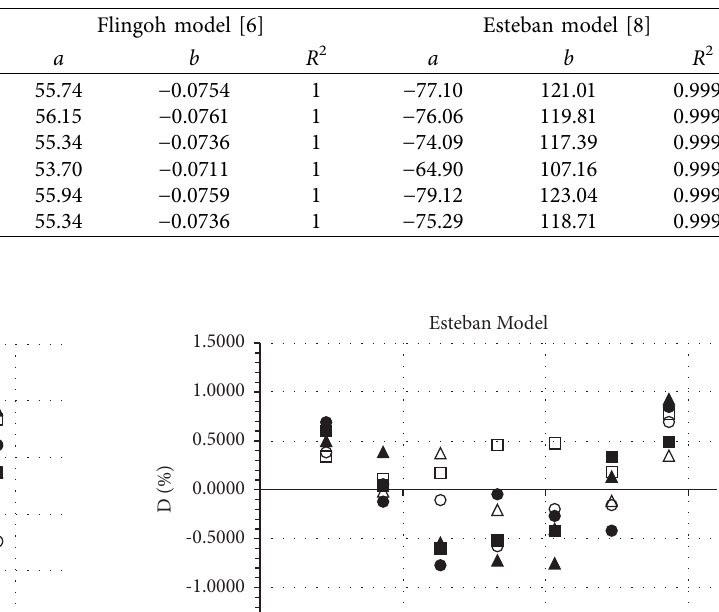
Table 4: Linear coefcient terms of the surface tension relationship.